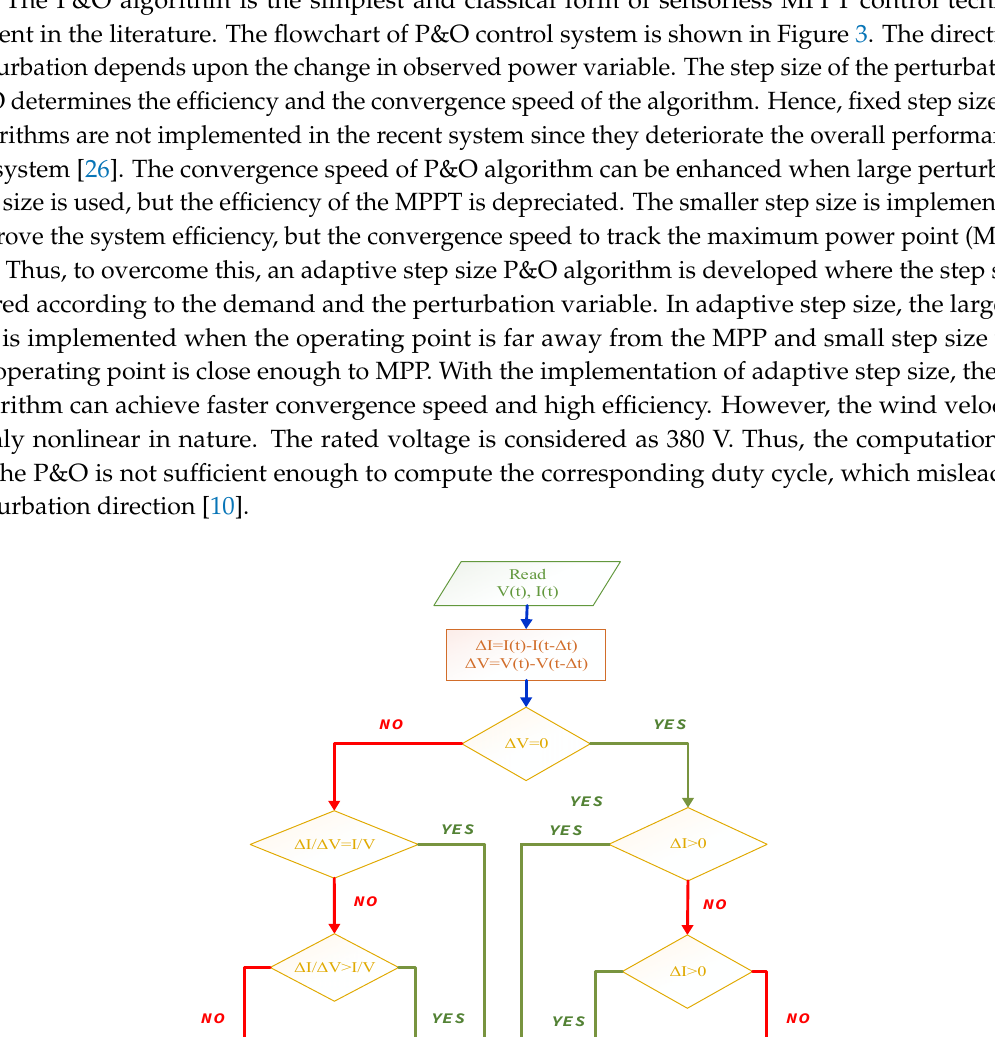
Figure 2. Proposed topology of maximum power point tracking (MPPT) and DC/DC converter. PWM: Pulse Width Modulation